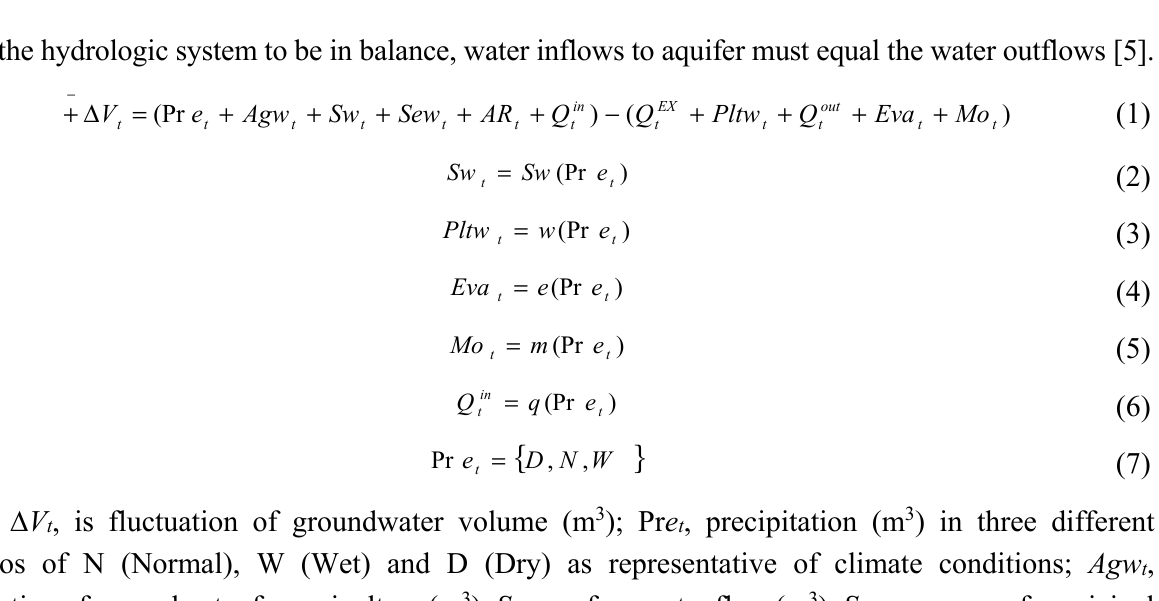
Figure 2. STELLA dynamic flow diagram of studied groundwater